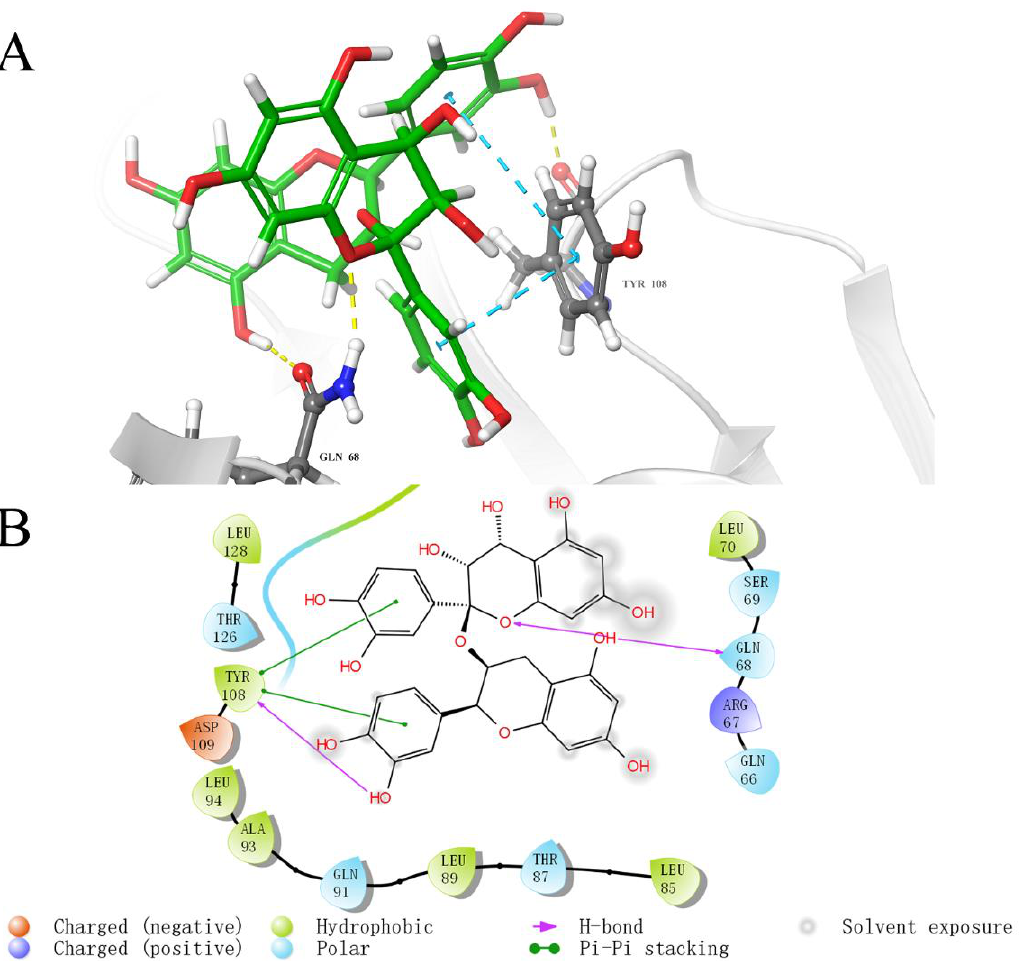
Figure 5. Molecular docking diagram of the interaction between procyanidin and LolB. ( A ): Detailed view of the LolB – procyanidin interaction sites. Amino acid residues involved in binding are shown in stick representation. H bonds are shown as yellow dashed lines and pi – pi stacking interactions are shown as cyan dashed lines. Procyanidin is labeled in green. ( B ): 2D diagram of interaction.